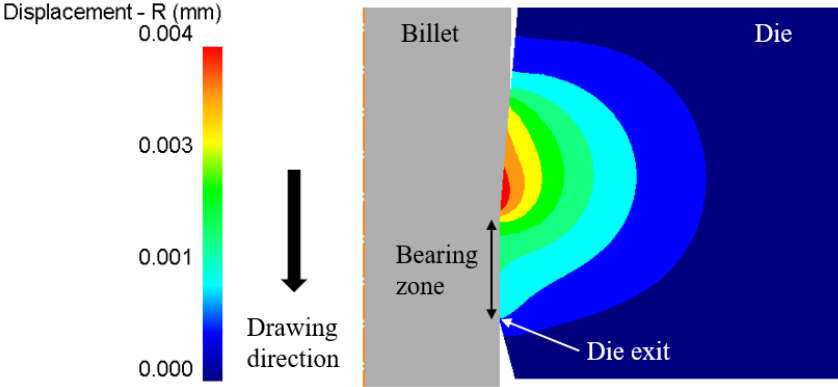
Figure 5. Displacement of the die in the radial direction during the drawing process.